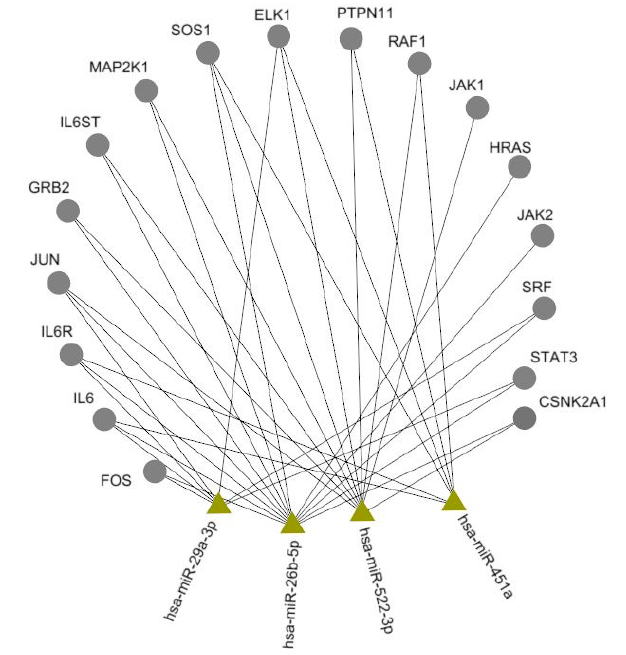
Figure 2. Associations of studied miRNAs with IL-6/IL-6R signaling pathway.